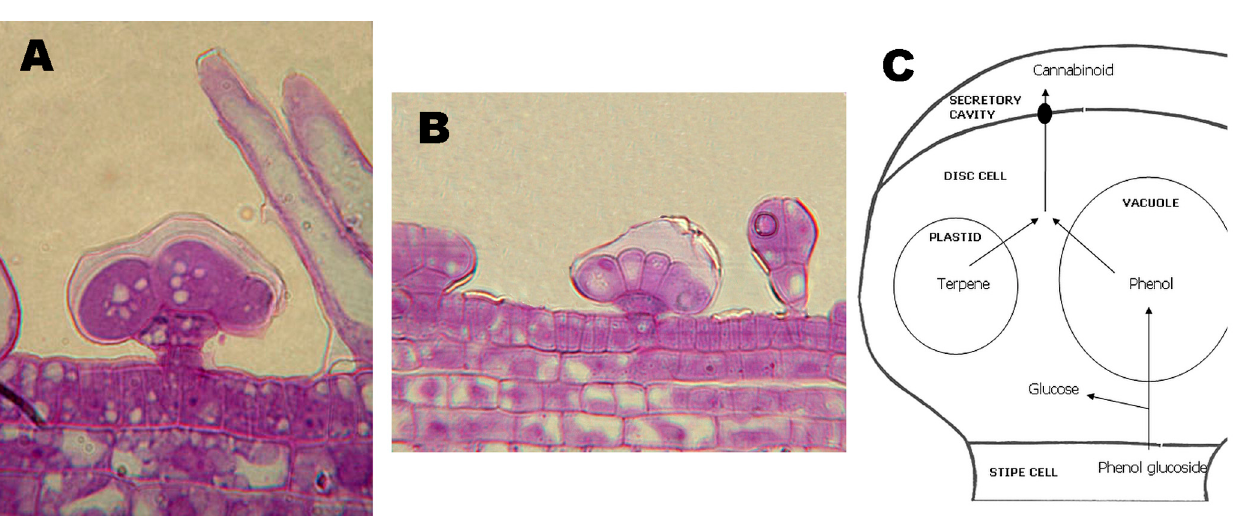
Figure 2. Capitate-sessile ( A ) and bulbous ( B ) glandular trichomes. In ( A ), also some non-glandular trichomes (not secerning) are visible. ( C ), schematic representation of the current model of secretion of cannabinoids from the